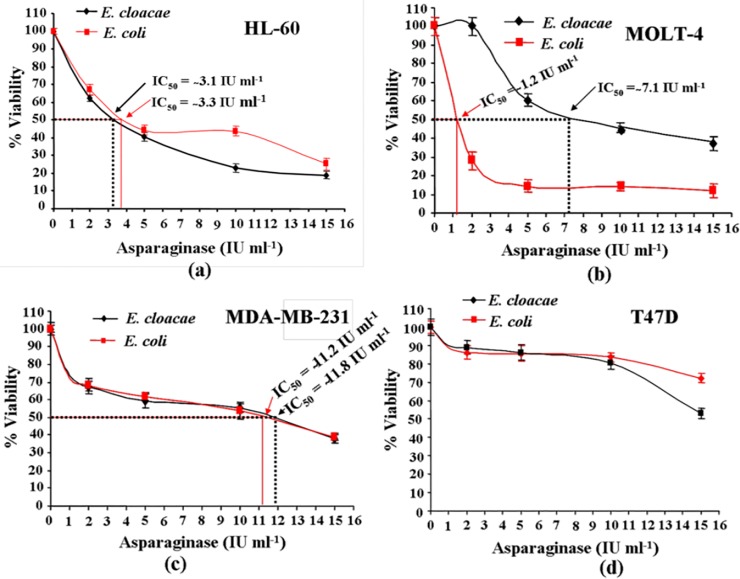
Dose-dependent effect of asparaginases on viability of human cancer cells.(a-d) MTT assay showing cytotoxic effect on HL-60, MOLT-4, MDA-MB-231, and T47D cells proliferation following treatment with purified asparaginase. Approximately, 1.5x104 cells ml-1 were cultured at 37°C, separately. Purified E. cloacae asparaginase and reference asparaginase preparation (E. coli asparaginase) procured from Sigma chemical Co. St. Louis were added at a concentration of 2, 5, 10, and 15 IU ml-1. After 48 h of treatments cells viability was determined by the MTT assay. Each value represents the mean ±SD for three determinations.